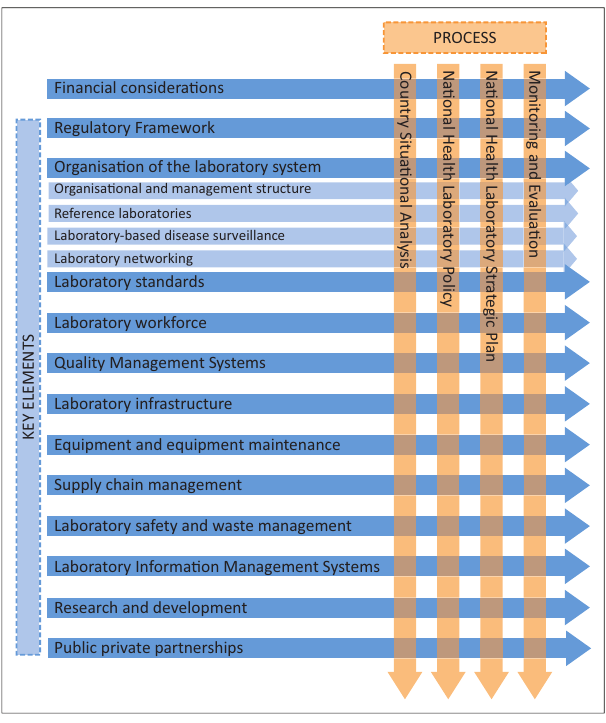
FIGURE 1: Key crosscutting elements of a National Health Laboratory